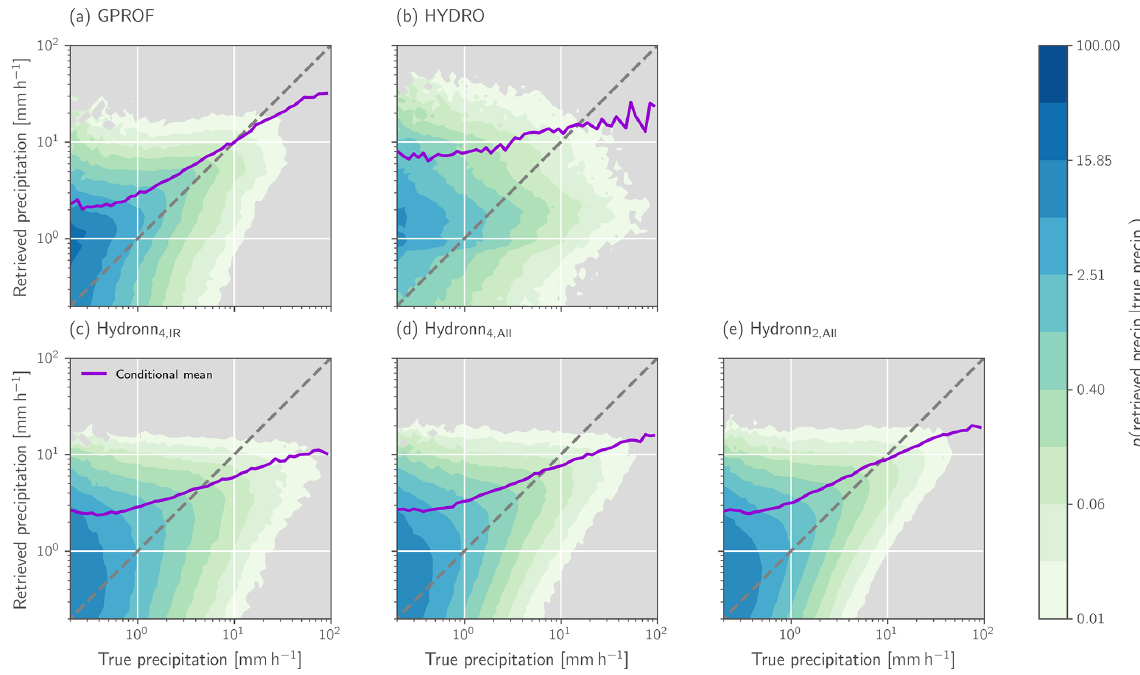
Figure 8. PDFs of retrieved precipitation conditioned on the reference precipitation for GPROF GMI, HYDRO, and the three Hydronn configurations. The purple line in each panel shows the mean of the retrieved surface precipitation conditioned on the reference precipitation.